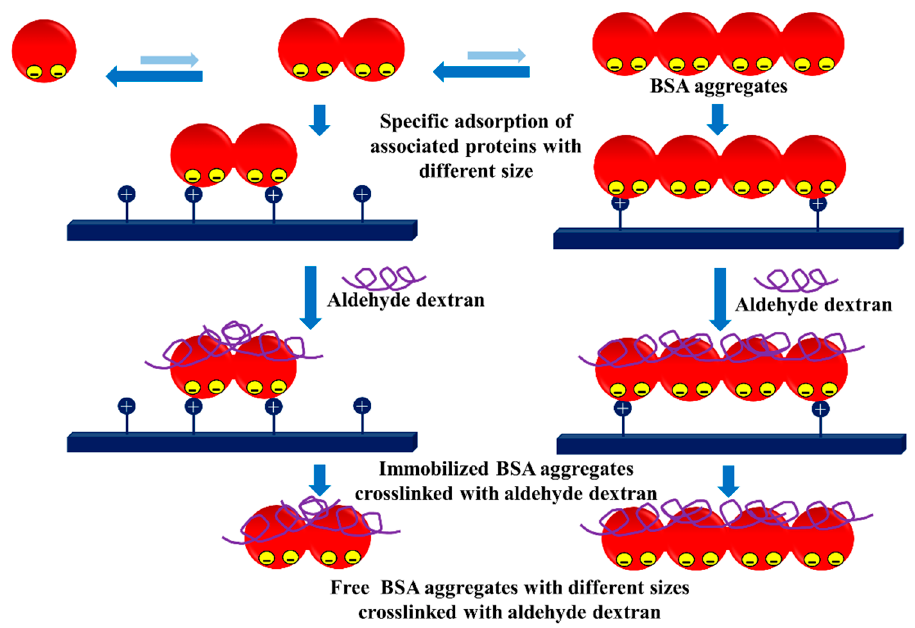
Figure 23. Shifting association equilibrium of weak enzyme complexes using lowly activated supports and final crosslinking of the immobilized complexes with dexOx.